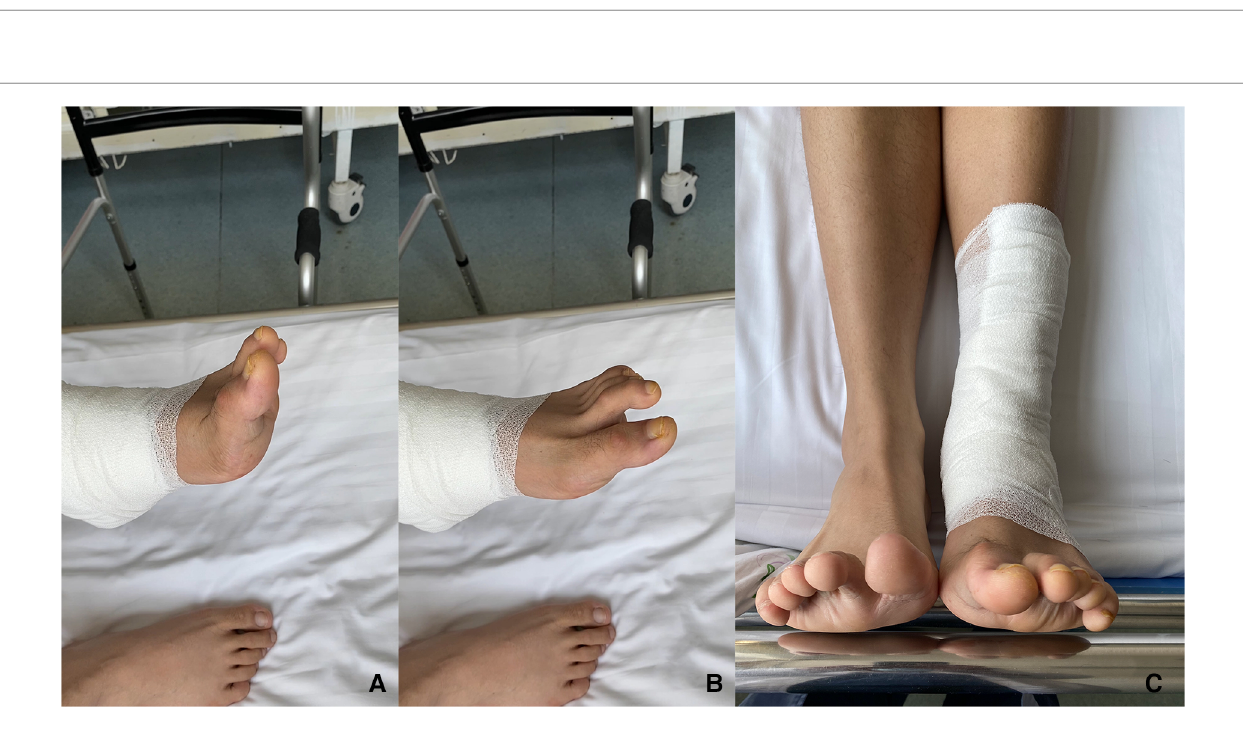
FIGURE 6 Macroscopic appearance of the left foot after surgical correction. Independent of the ankle position, dorsi fl exion ( A ), plantar fl exion ( B ), neutral ( C ), and the range of motion of the hallux and second toe was